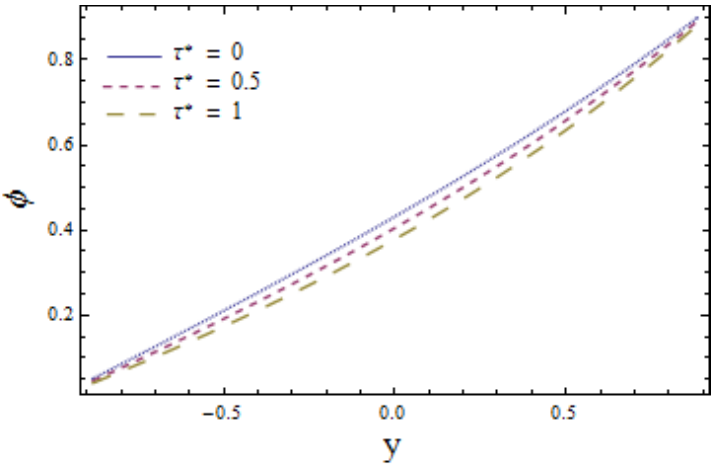
Figure 17. Mass concentration φ versus y for τ ∗ when (cid:101) = 0.2, x = 0.1, t = 0.1, γ h 1 = 6, γ h 2 = 8, γ m 1 = 6, γ m 2 = 8, γ = 1.5 and Sc =